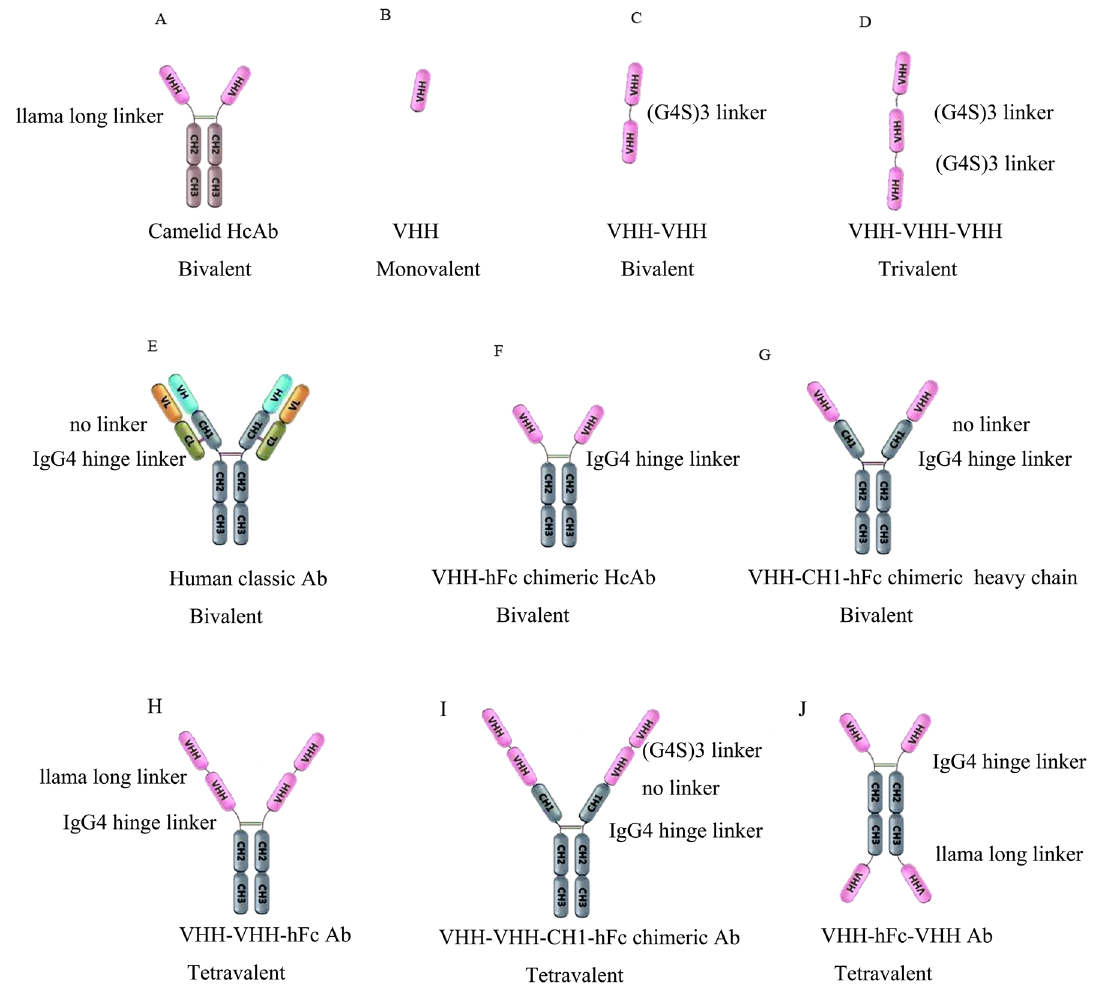
Figure 3. Schematic representation of Ab configurations. Schematic representation of different Abs’ configurations. ( A ) HcAb has its llama hinge linker: bivalent; ( B ) Camelid VHH: monovalent; ( C ) VHH- (G4S)3-VHH: bivalent; ( D ) VHH-(G4S)3-VHH-(G4S)3-VHH: trivalent; ( E ) Human classic Ab with its hinge linker: bivalent; ( F ) Llama VHH-human IgG4 hinge linker-IgG4 Fc chimeric HcAb: bivalent; ( G ) Llama VHH-human CH1-IgG4 hinge linker-IgG4 Fc chimeric heavy chain: bivalent; ( H ) VHH-llama long linker- VHH-human IgG4 hinge linker-IgG4 Fc: tetravalent; ( I ) VHH-(G4S)3 linker-VHH-human CH1-IgG4 hinge linker-IgG4 Fc chimeric Ab: tetravalent; ( J ) VHH-human IgG4 hinge linker-IgG4 Fc-llama long linker-VHH chimeric Ab: tetravalent. Thus, “(G4S)3” is a 15-peptide linker (amino acid sequence: GGGGSGGGGSGGGGS). “IgG4-hinge linker” means the hinge region between the human Fab and human IgG4 Fc (amino acid sequence: PPCPSCPAPEFLGGPS). “Llama long linker” means the hinge region between the llama Fab and llama IgG2 Fc (amino acid sequence: